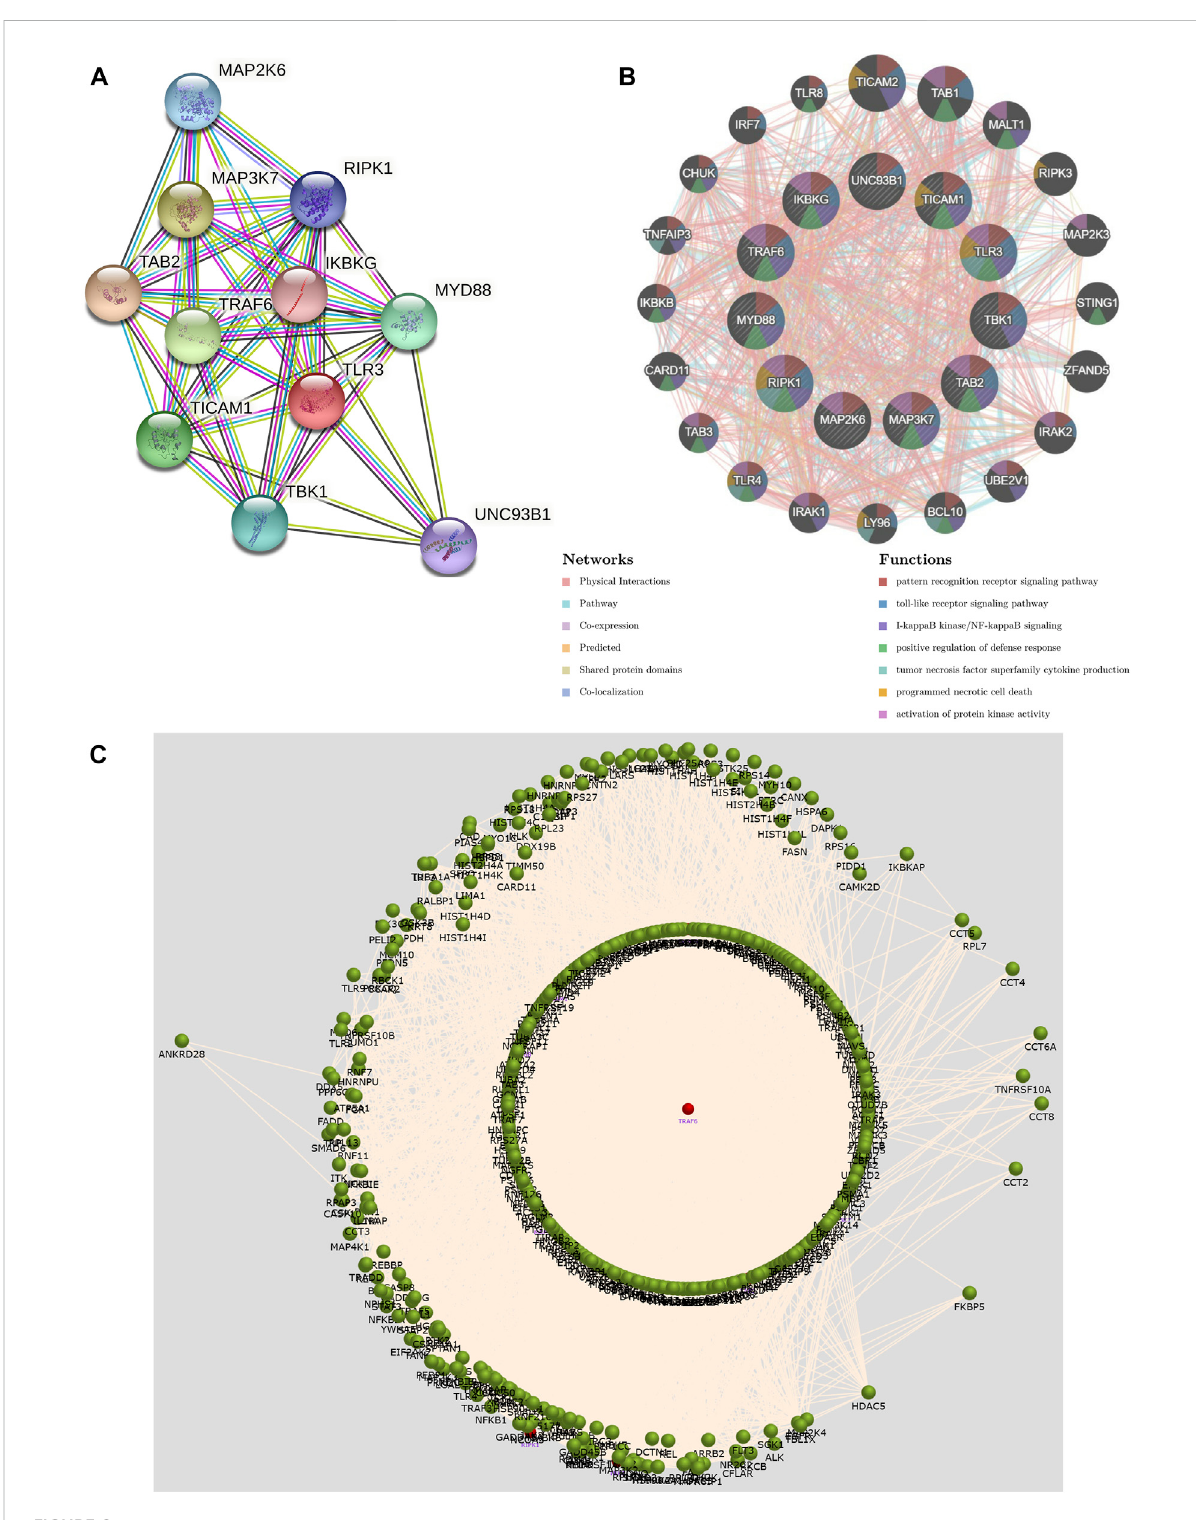
FIGURE 8 ThePPInetworkandfunctionofTLR3anditsinteractinggenesandthekeygenethatregulatestheirexpression. (A) ThePPInetworkofTLR3. (B) The PPI network and functions of TLR3 and its interacting genes. (C) Interaction plot showing that the key gene affecting TLR3 and its interacting genes is